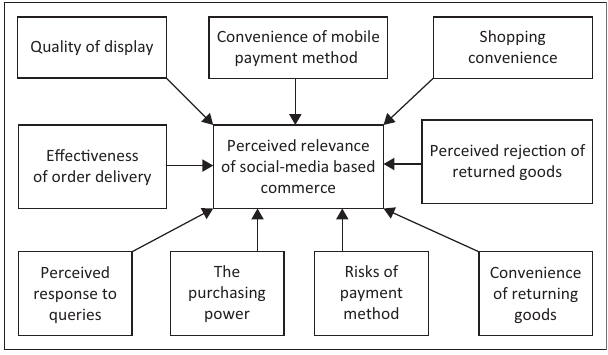
FIGURE 1: Conceptual framework – The perceived relevance of social media- based m-commerce. TABLE 1: Components of the research